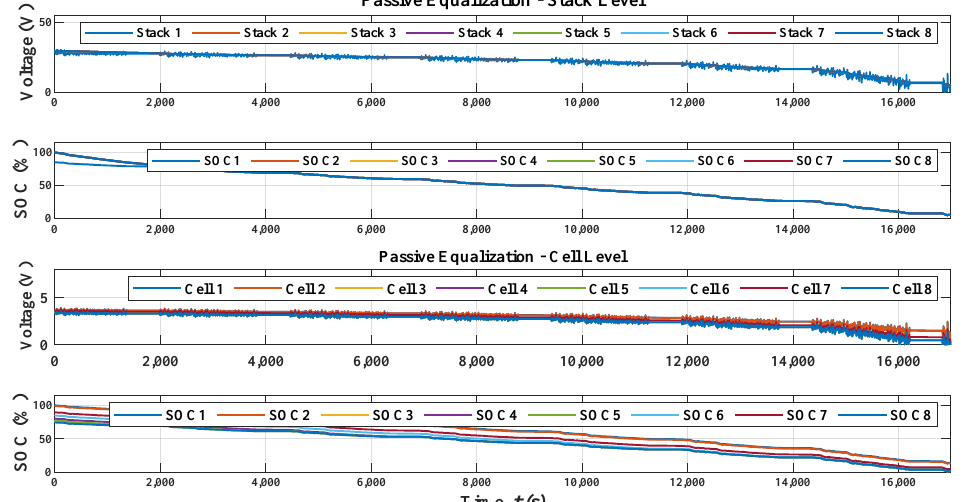
Figure 12. Simulation results of the EV model. Details of voltage and SOC behavior of passive equalization at stack and cell